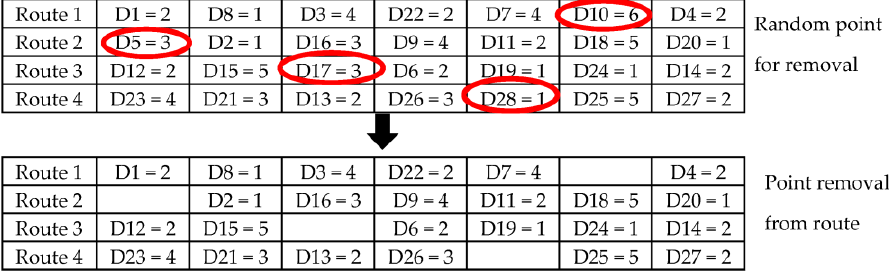
Figure 2. Example of random removal for solution destruction.